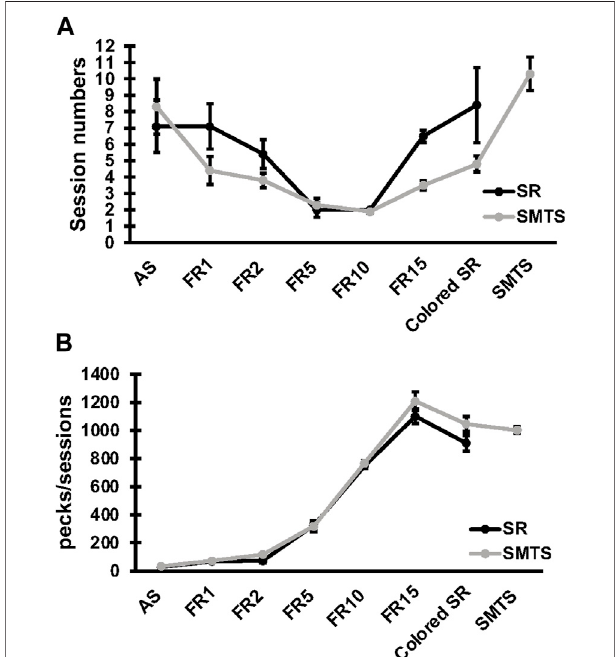
FIGURE 3 | Learning curve and pecking activity of the two pigeon groups. The learning curve in (A) shows the session numbers for each step of the behavioral training by means ± SEM for each group (N = 10, SR and SMTS).Attheendofthetrainingallpigeonsreachedaperformancelevel of 80% correct responses in both tasks (SR and SMTS). Both groups performed an equal total amount of sessions. In parallel, in (B) the pecking activity during the learning periods is presented by means ± SEM for each group (N = 10, SR and SMTS). Abbreviations: AS, autoshaping; FR1 to FR15, fi xed ratio 1 to 15; Colored SR, Stimulus-Response task including color; SMTS, Simultaneous-Matching-To-Sample